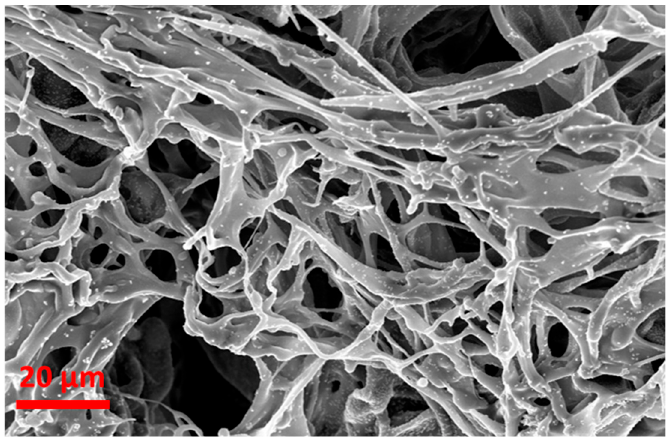
Figure 9. SEM micrograph of the hydrogel 3D structure after removing water of the sample (C P = 0.5 wt%, pH 7.4) by freeze